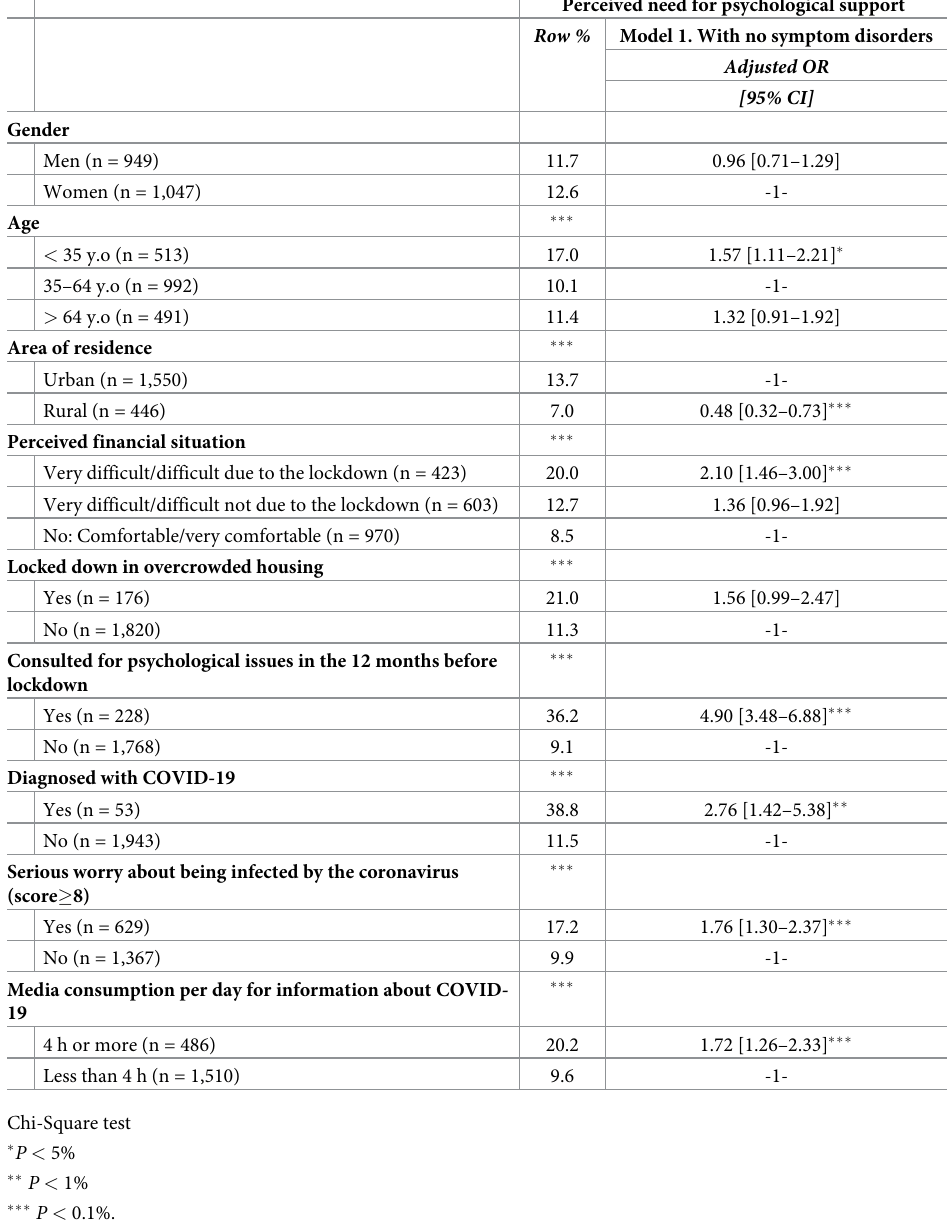
Perceived need for psychological